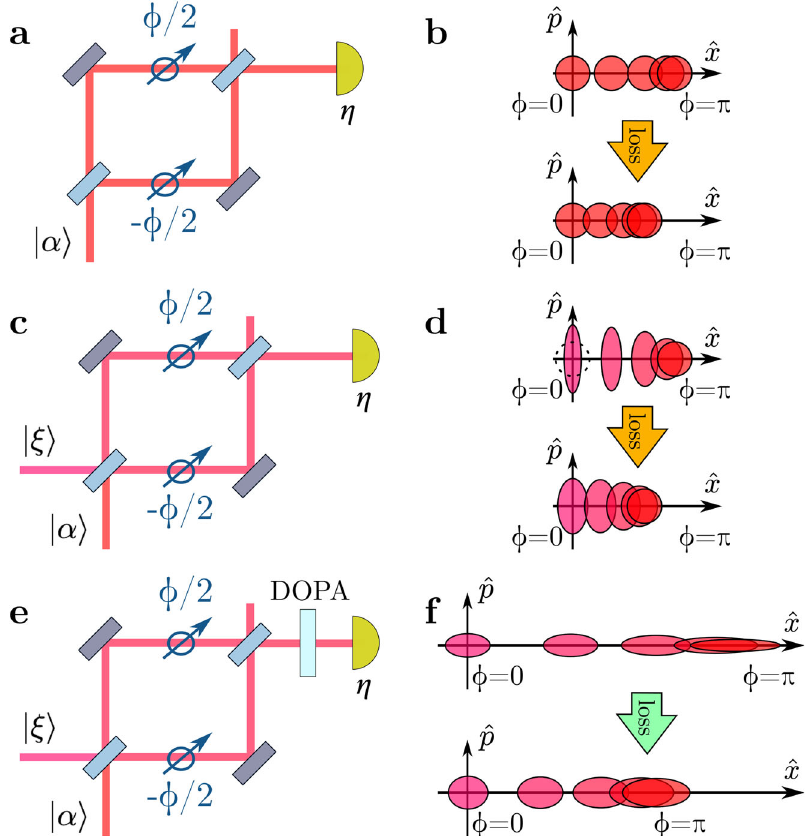
Fig. 1 Overcoming detection loss in squeezing-assisted interferometry. Panels a , c , e show the experimental schemes and panels b , d , f , the calculated Wigner functions of the output states for fi ve equidistant phases. a This ideal Mach-Zehnder interferometer fed with a coherent state α j i has the best phase sensitivity at ϕ = 0, the detector seeing the `dark fringe', where the output states for different phases are most distinguishable ( b ). c If, additionally, the second input port is fed with squeezed vacuum (SV) ξ j i , the neighboring states are squeezed and better distinguishable; however loss or imperfect detection ef fi ciency η makes them overlap ( d ). e To overcome the loss, a degenerate optical parametric ampli fi er (DOPA) ampli fi es the state before detection. f The output states are now anti-squeezed in the quadrature carrying the phase information; the latter is therefore protected against loss. In the calculation, α = 3, η = 0.5, ξ j i is 6 dB squeezed, and DOPA provides 9.6 dB quadrature